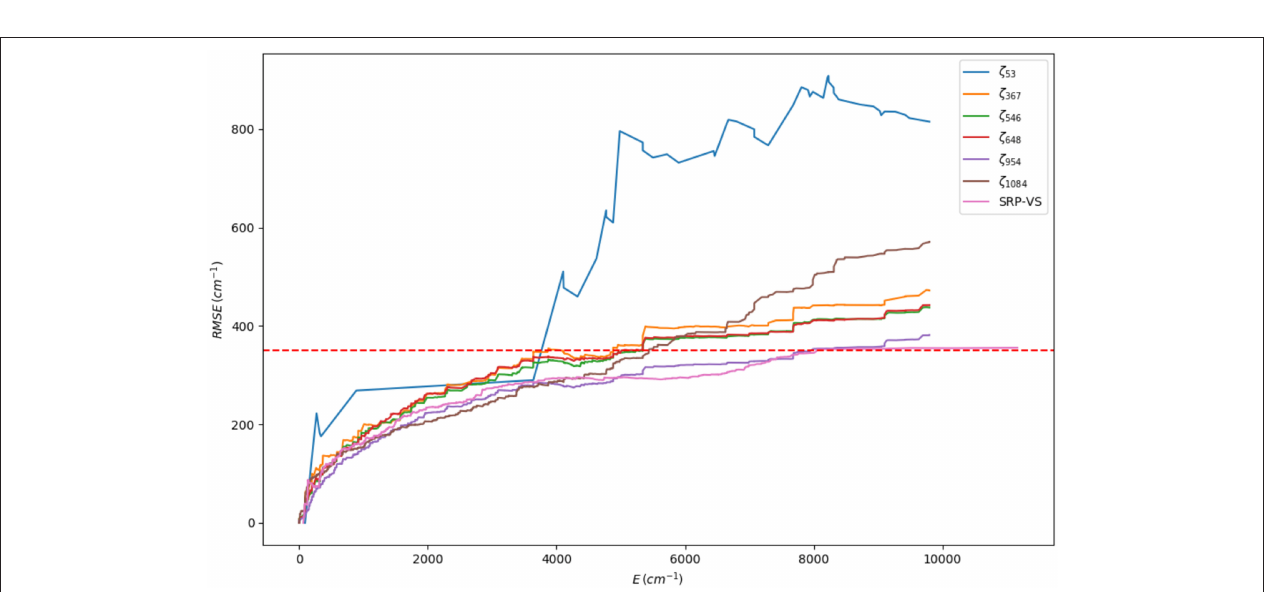
FIGURE 5 | Cumulative RMSE for each SRP-fit labeled by its set of parameters, ζ N , where N is the number of points used in the fit (see Table 1 ). The last set ( ζ VS ) corresponds to the validation set. The red dotted horizontal line represents the value of the chemical accuracy (1 kcal/mol ≈ 350 cm − 1 ).